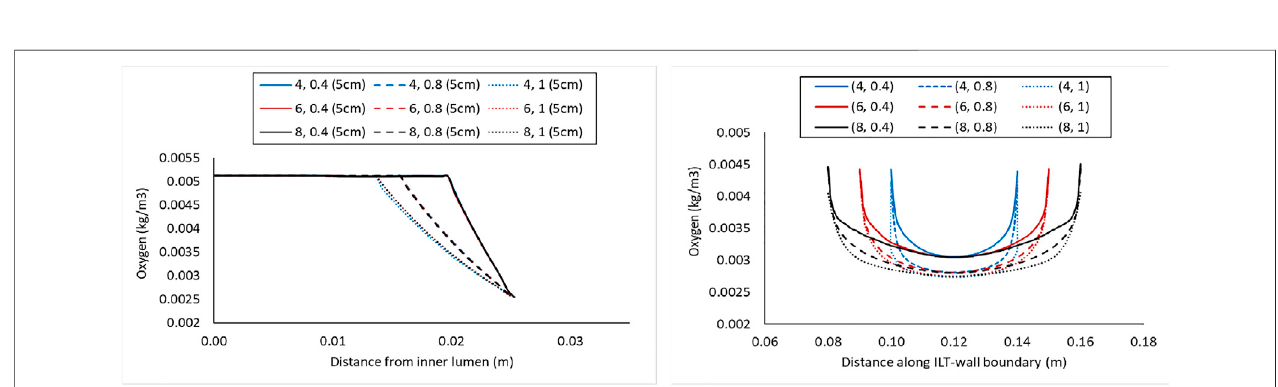
FIGURE 5 | Comparison of the oxygen concentration along a radial path line at halfway along the length of the lumen in the cases with BD = 5 cm and varying ILT length( l )and ILTthickness( δ ) denoted bycase ( l , δ ) (left),and comparison oftheoxygenconcentrationalongtheaxial lengthon theinteriorinterfaceofthearterialwall in the same cases (right). In both plots, the blue, red, and black lines represent the short, medium, and long ILT cases information respectively; and solid, dashed, and dotted lines represent thin, moderate, and thick ILT cases respectively. Cases are presented in Figure 2 . Path lines are demonstrated in Figure 4